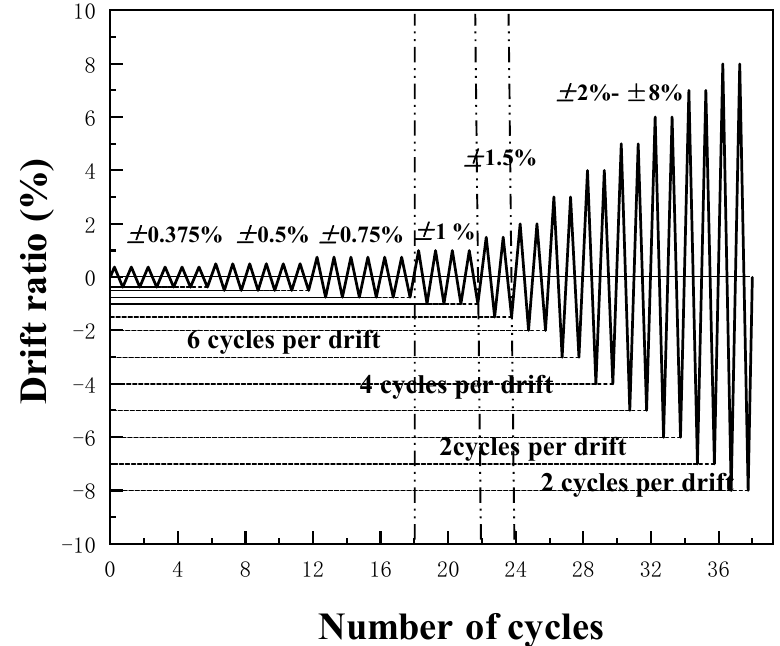
Figure 4. Loading protocol.